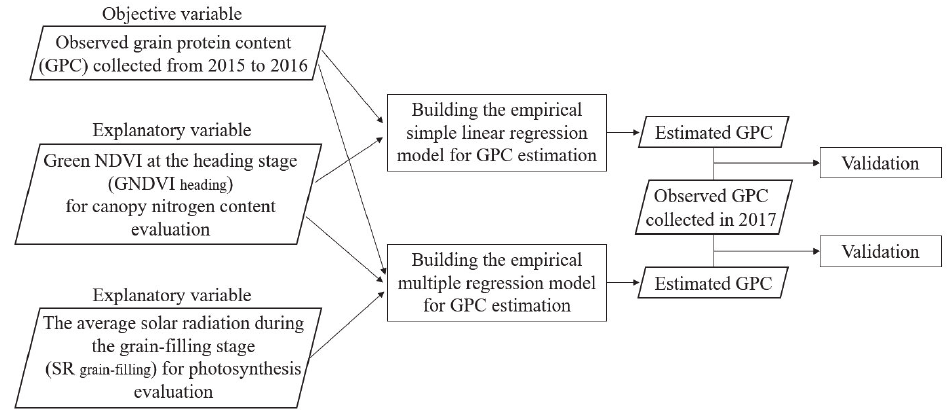
Figure 2. The process of grain protein content (GPC) estimation.